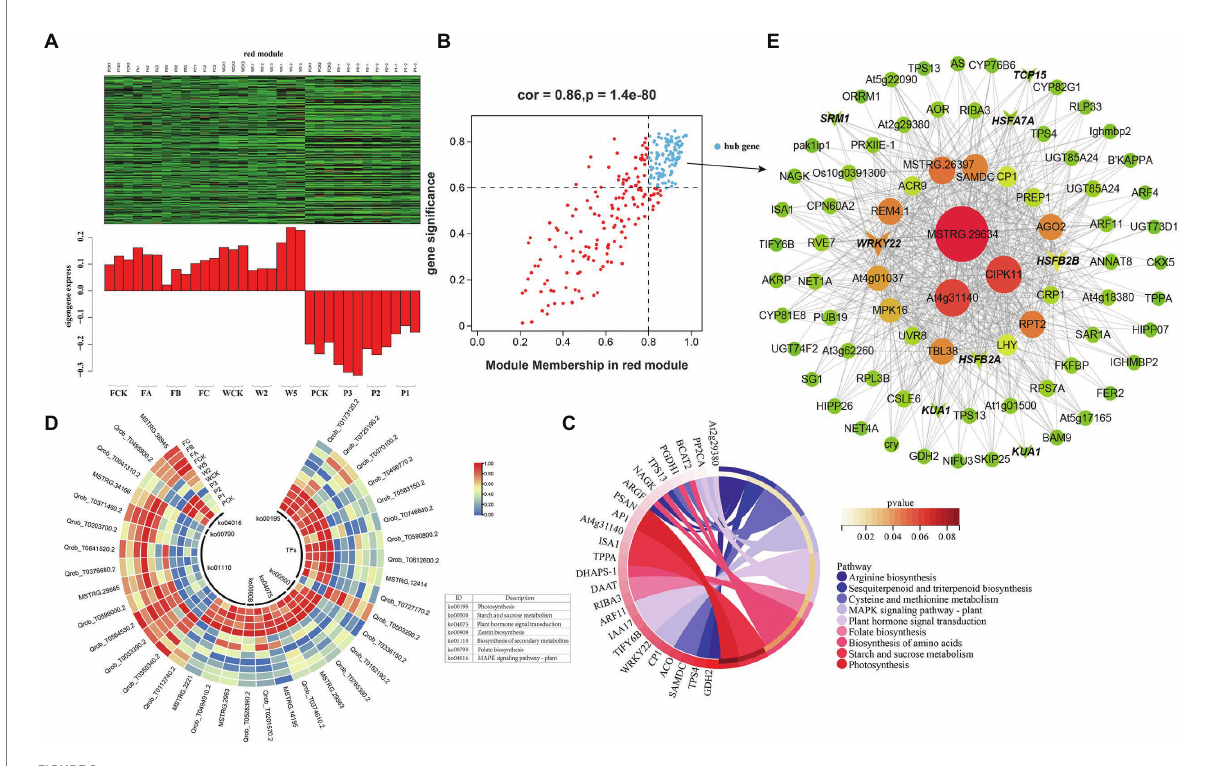
FIGURE 8 Coexpression network of the red module. (A) Gene coexpression heat map of the red module (upper panel) and expression of the corresponding eigengenes in each sample (lower panel). (B) Soluble sugars and the red module have a point map of the hub gene with higher connectivity and expression. The x axis represents the correlation between the expression of each gene and the module, and the y axis represents the correlation between each gene and the trait. (C) KEGG enrichment loop diagram of hub genes related to soluble sugar traits in the module. (D) Heat map of hub gene expression associated with soluble sugar traits. (E) Coexpression network of hub genes in the red module. The first 100 hub genes with a weight value >0.30 and higher expression were used to construct the